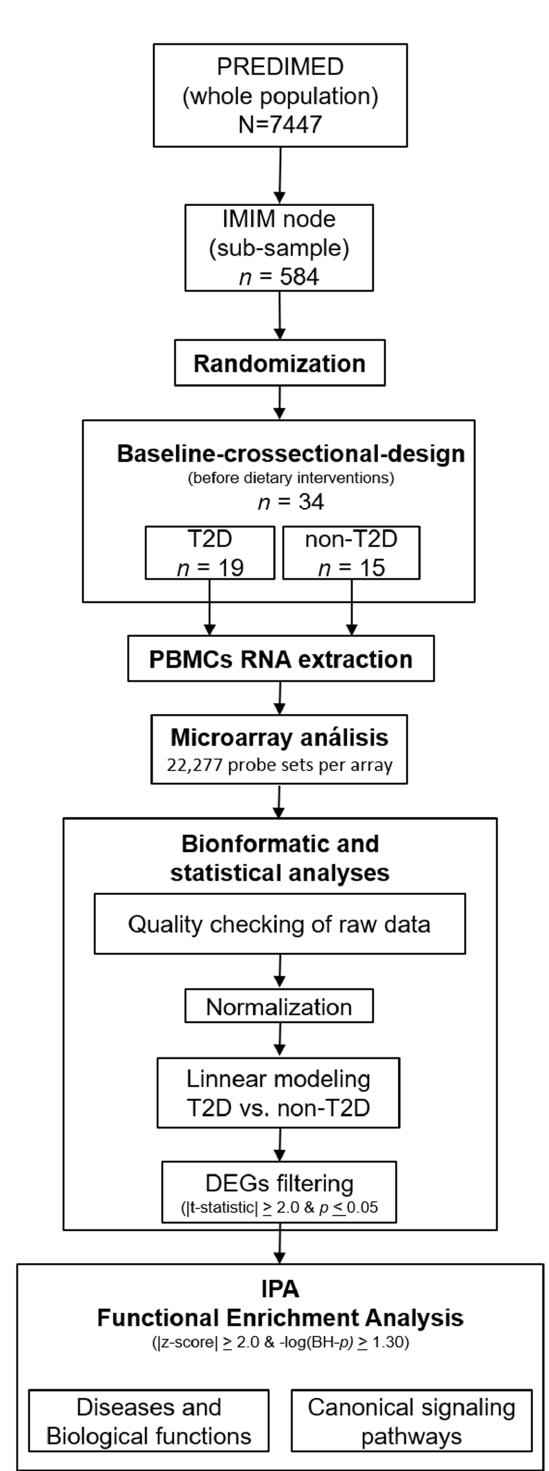
Figure 1. Participant and data analysis flowchart followed in the current study. Abbreviations: BH-P, Benjamini–Hochberg-adjusted p value; DEGs, differentially expressed genes; IMIM, Hospital del Mar Research Institute; IPA, Ingenuity Pathway Analysis; non-T2D, non-type 2 diabetes; PBMC, peripheral blood mononuclear cells; PREDIMED, Prevenci ó n con Dieta Mediterr á nea; T2D, type 2